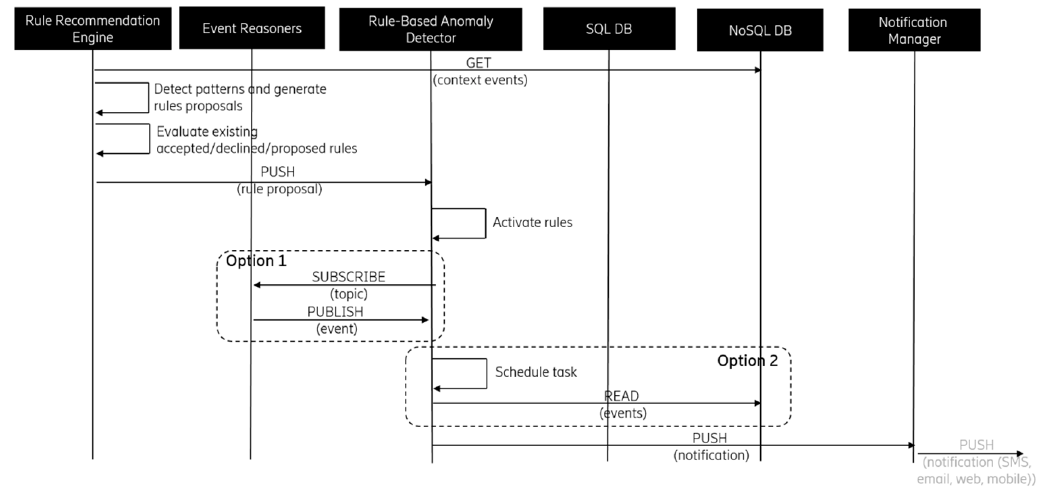
Figure 7. rule-based anomaly detection flow.